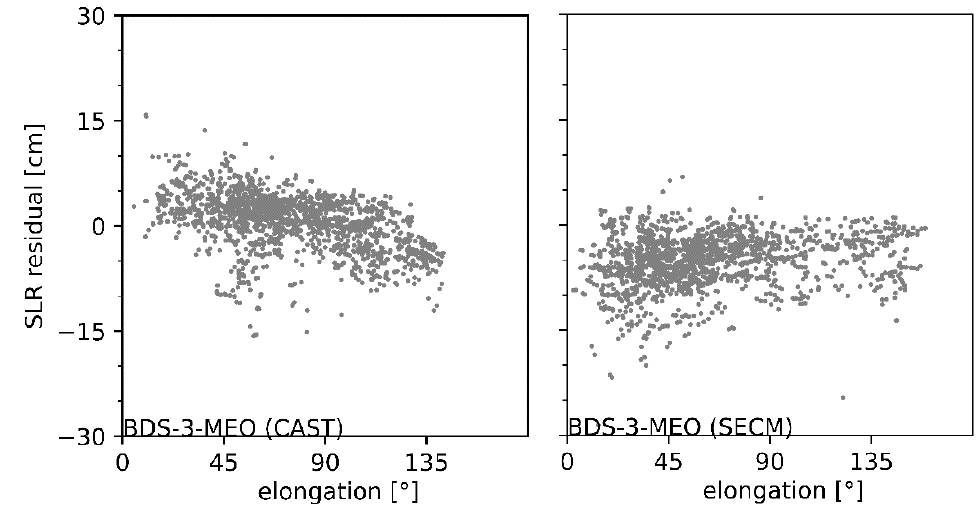
Figure 11. SLR residuals of BDS satellites manufactured by CAST ( left panel ) and SECM ( right panel ) as a function of satellite elongation angle for.